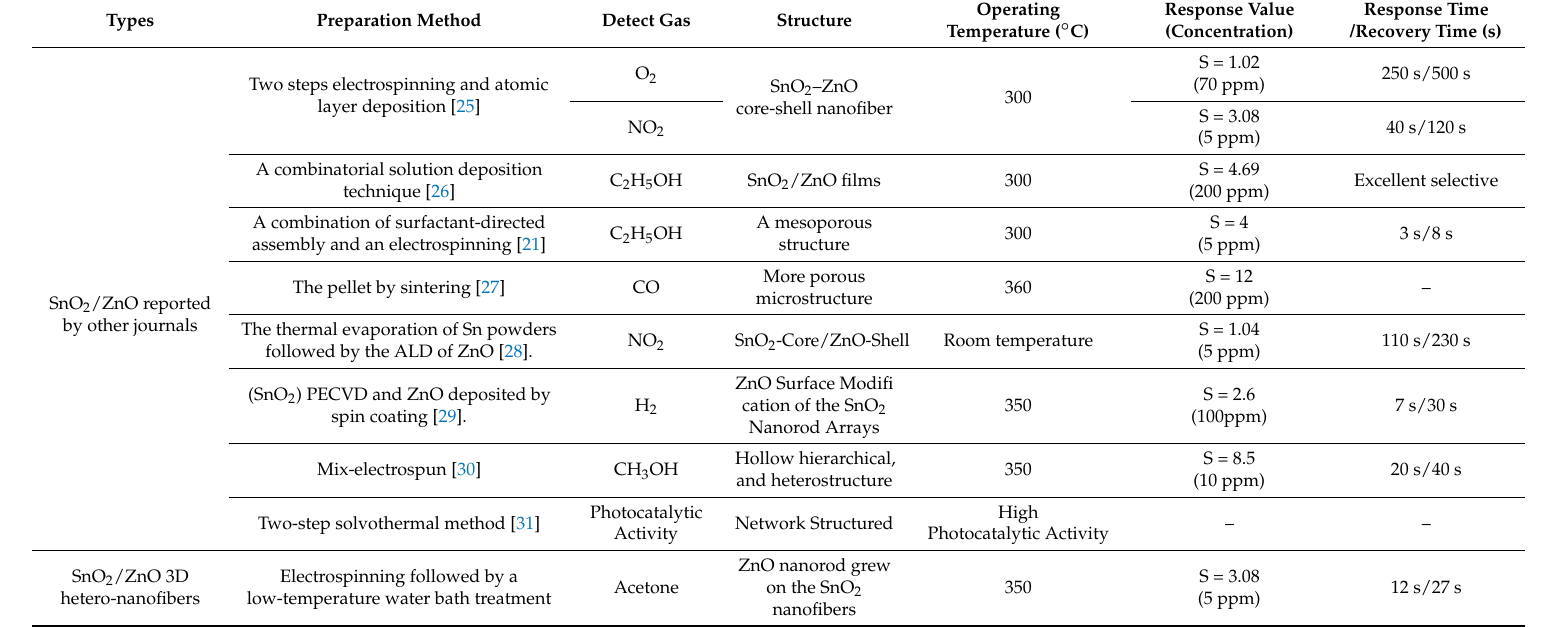
Table 2. Comparison of the gas sensor based on SnO 2 /ZnO composites and their gas-sensing